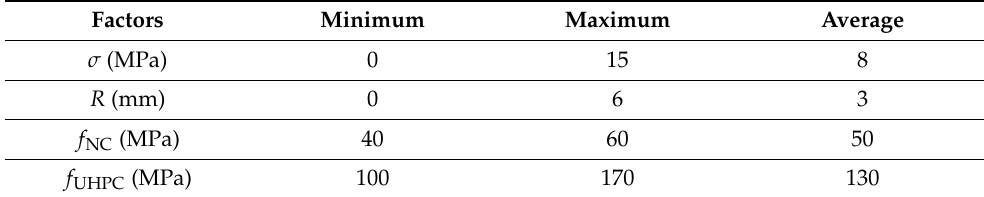
Table 6. The main influencing factors.